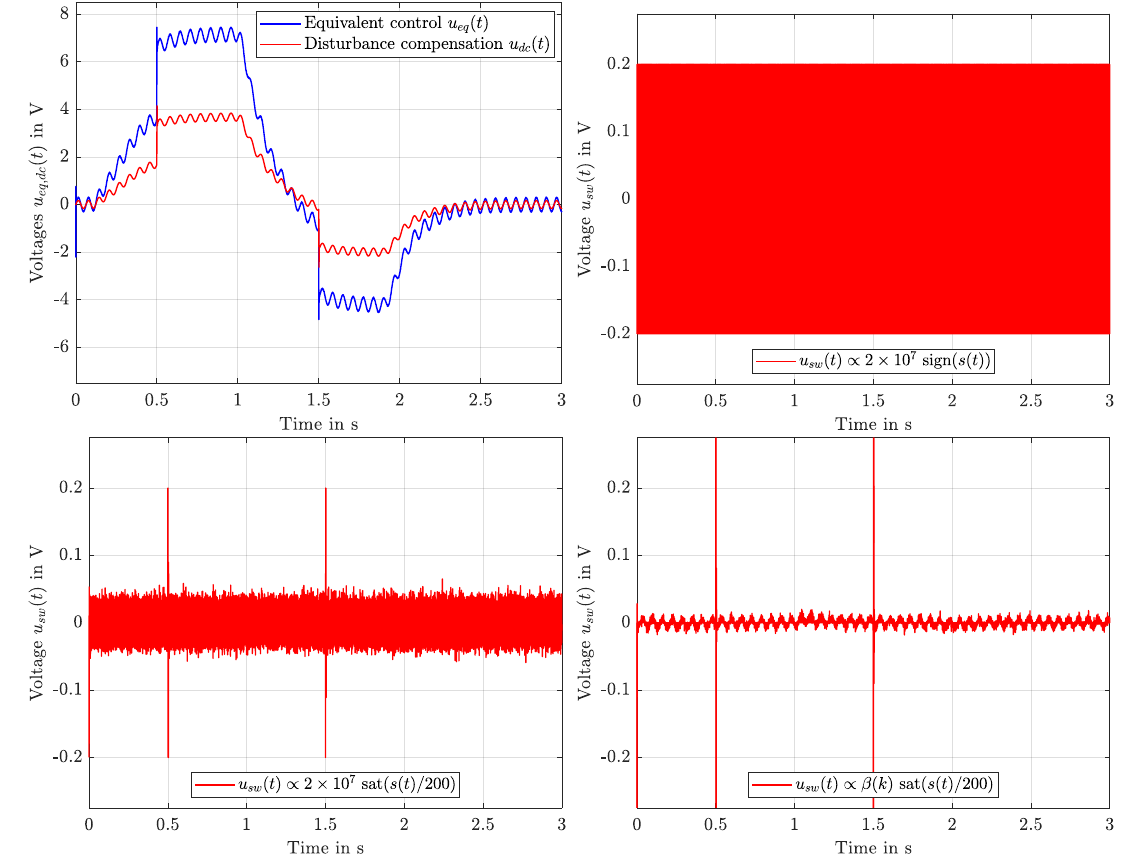
Figure 8. Comparison of the control inputs u : contribution of the equivalent control law and the disturbance compensation ( top , left ); detailed plots for all the variants ( top , right ; bottom